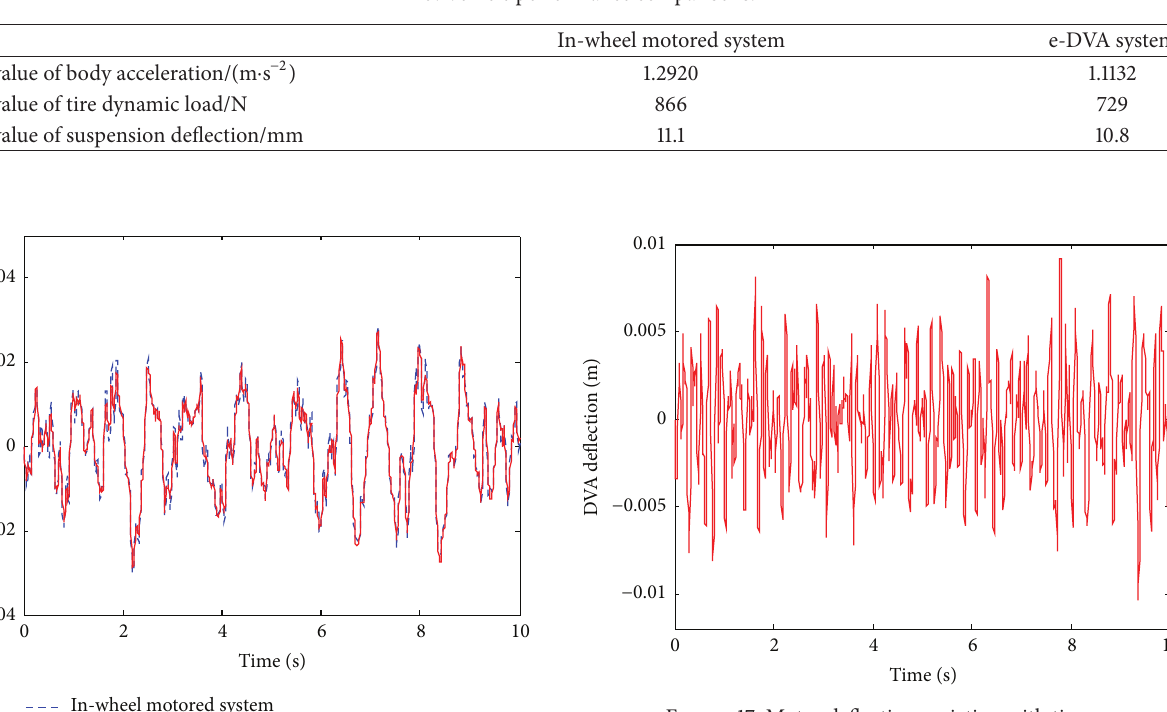
Table 3: Vehicle performance comparisons.